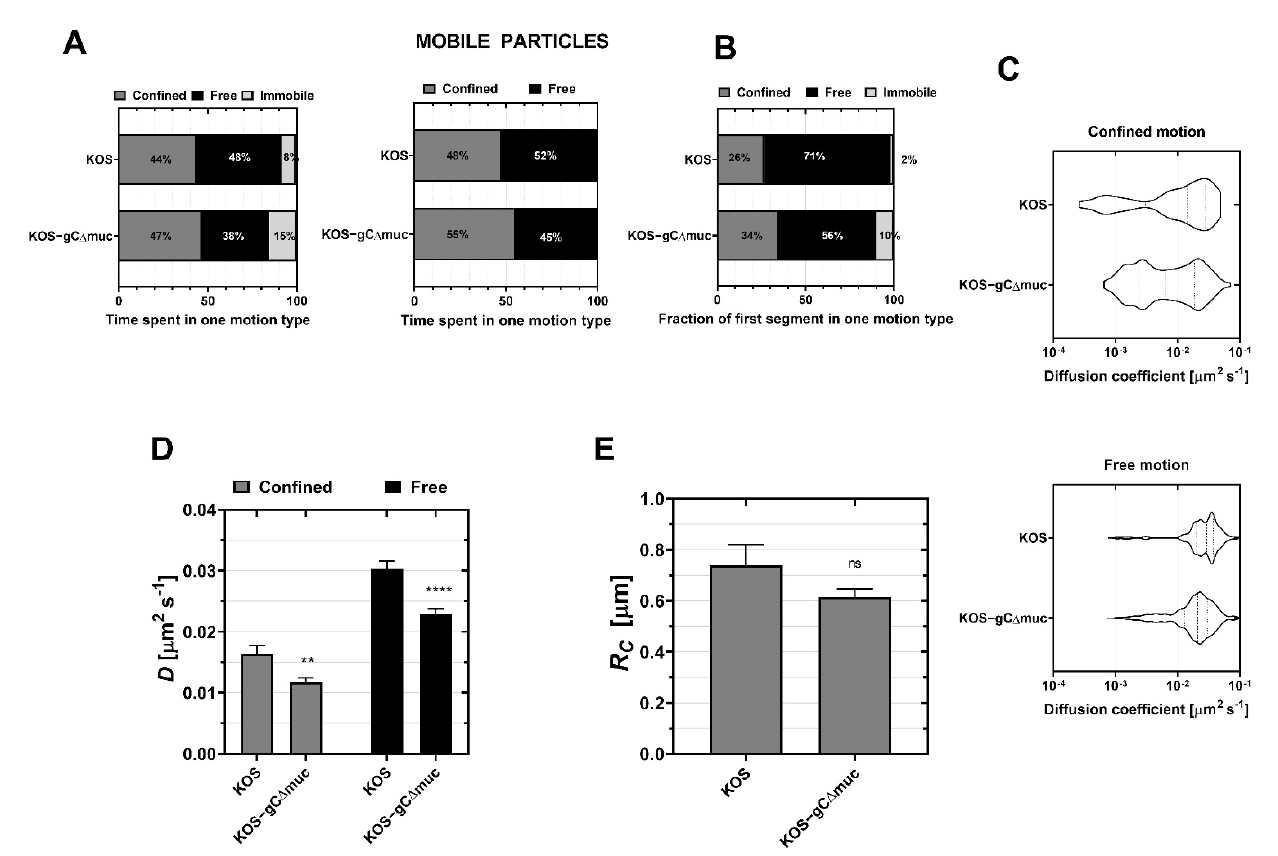
Figure 4. Influence of the mucin-like domain (MLD) of the glycoprotein gC on the interaction of HSV-1 with the HaCaT cell surface upon landing. The diffusion of HSV-1 (KOS strain) and the mutant HSV-1 lacking the MLD (KOS-gC Δ muc) are recorded on HaCaT cells. ( A ) Left: The fraction of the total time spent by KOS and KOS-gC Δ muc in one of the motion types: confined (grey), free (black) and immobile (light gray). Right: The fraction of the total time spent by the two virus strains in the one of the mobile motions: confined (grey) and free (black) ( B ) The fraction of first segments in one of the three motion types. ( C ) Distributions of the diffusion coefficients plotted in violin plots. ( D ) The mean diffusion coefficients D of the confined and free motions were calculated for KOS and KOS-gC Δ muc. ( E ) The confinement radius R C of the confined motion. The total number of landing viruses recorded here is 80 and 201 for KOS and KOS-gC Δ muc, respectively. Asterisks denote a significant difference by Welch t -test: ns = not significant, ** p ≤ 0.01 and **** p ≤ 0.0001 relative to control. The fraction percentage ( A-B ) is obtained from counting, so no statistical analysis is pro- vided.